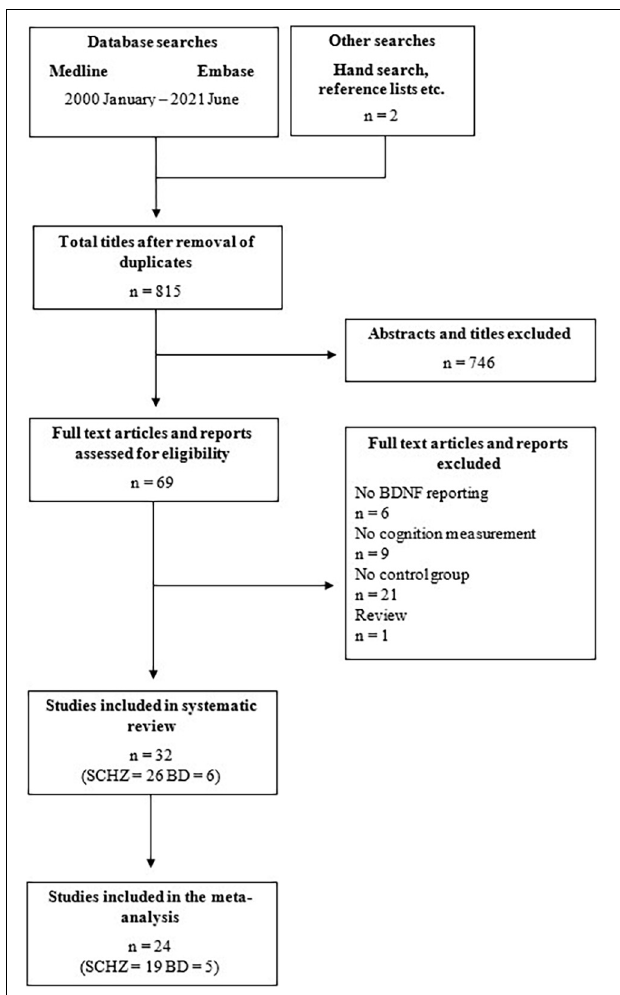
FIGURE 1 | PRISMA flowchart demonstrating the search strategy that was utilized for the systematic review and